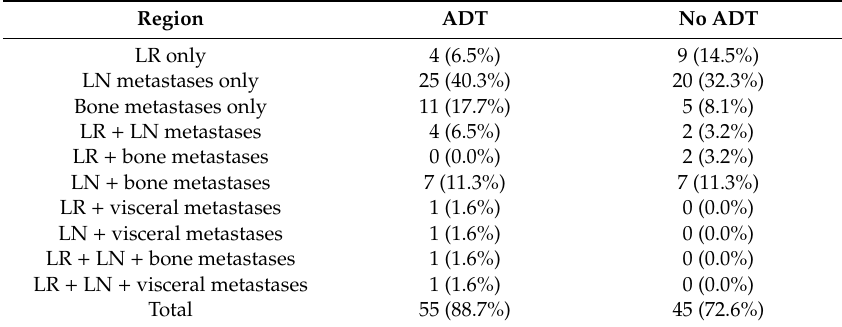
Table 3. Spreading of prostate cancer recurrence in 68 Ga-PSMA I&T PET / CT.